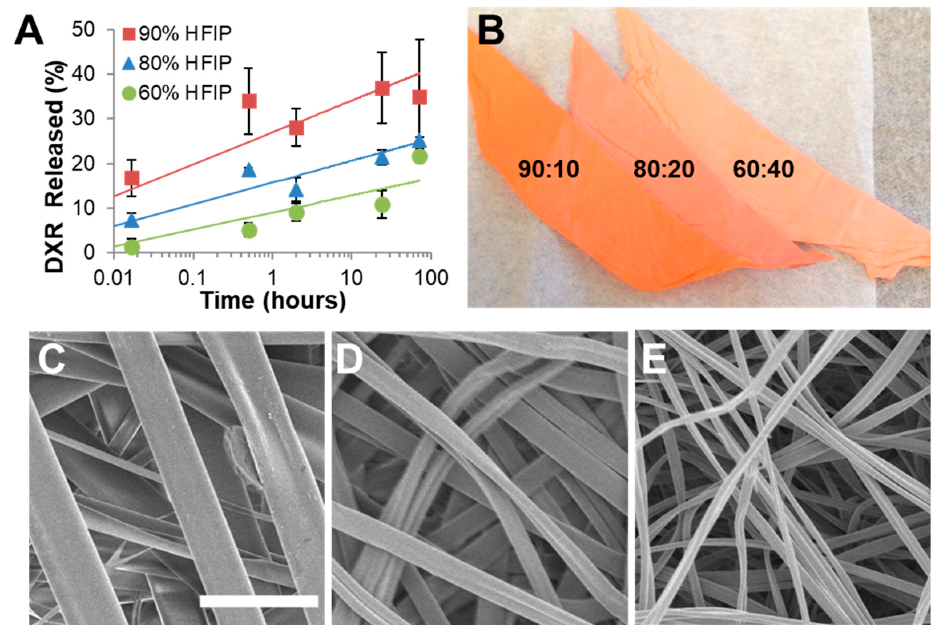
Figure 8. Effect of solvent system on drug solubility. ( A ) Burst release of DXR from Ace-DEX scaffolds electrospun with different HFIP to butanol ratios of 90:10 (black square), 80:20 (gray triangle), and 60:40 (white circle). ( B ) Picture of three different doxorubicin (DXR)-loaded Ace-DEX scaffolds electrospun with different solvent systems: hexafluoroisopropanol (HFIP) and butanol with ratios of 90:10, 80:20, and 60:40 (from left to right). Scanning electron micrographs of Ace-DEX/5Dox scaffolds electrospun in a solvent system of hexafluoroisopropanol (HFIP) and butanol with ratios of ( C ) 90:10, ( D ) 80:20, and ( E ) 60:40. Scale bar is the same for all images and represents 5 µ m. Slightly modified and reproduced with permission from